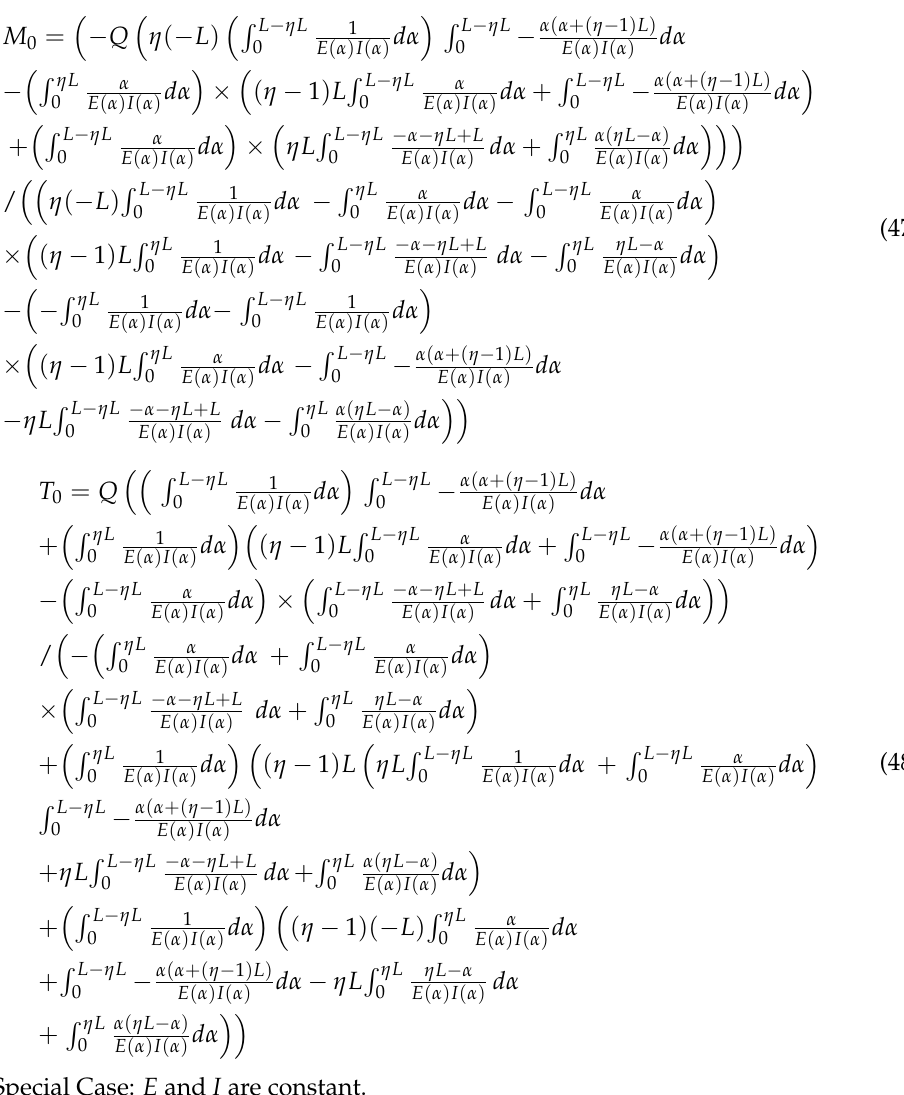
Figure 9. ( a ) Fixed beam with both ends subjected to singular force; ( b ) fixed-pinned beams subjected to singular force. Two other initial values ( M 0 and T 0 ) are obtained using Equations (25) and (26) follows.